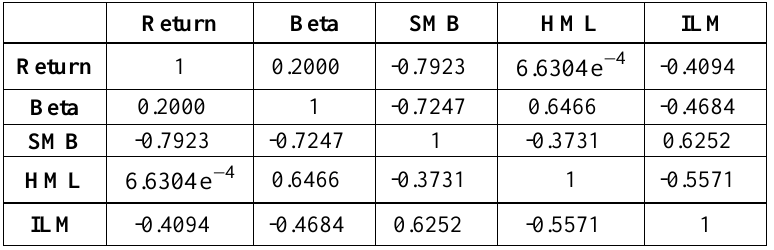
Table 3. Correlation Coefficients of Variables at the Sixth